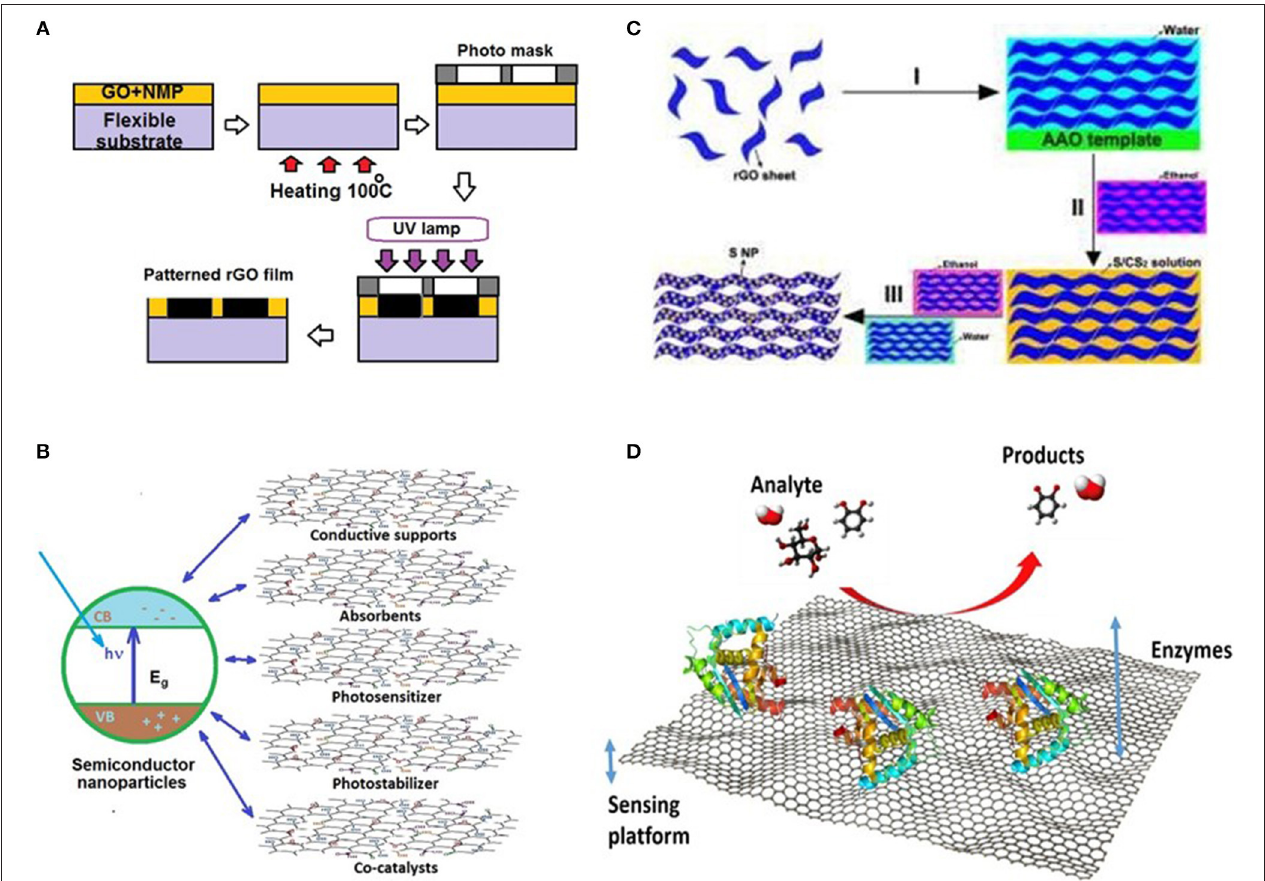
FIGURE 4 | Examples for applications of GO and rGO. (A) Schematic for patterning of GO-rGO films on a flexible substrate under UV illumination for applications in flexible electronics. Accordingly to Sonia et al. [64] Copyright 2018, Elsevier, Inc. (B) Functions of GO and rGO in graphene based composites for